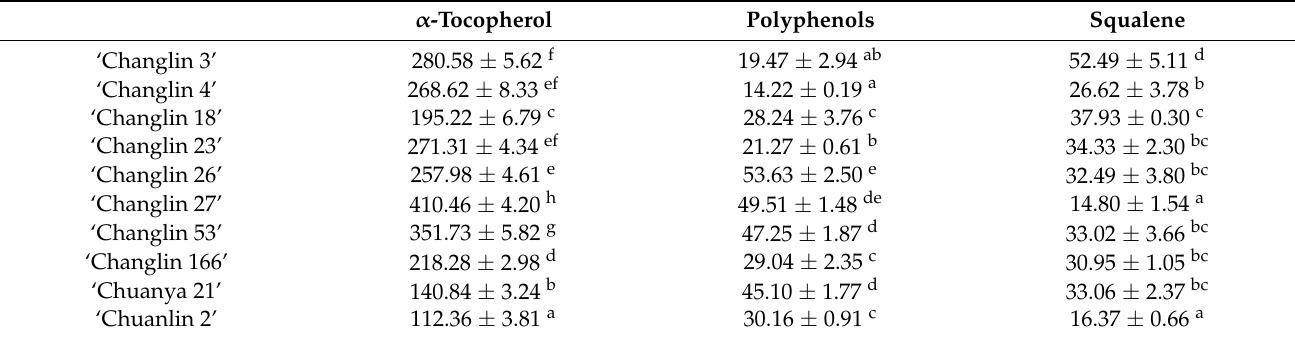
Table 3. Content of tocopherols, polyphenols and squalene in C. oleifera oil of ten cultivars (mg/kg